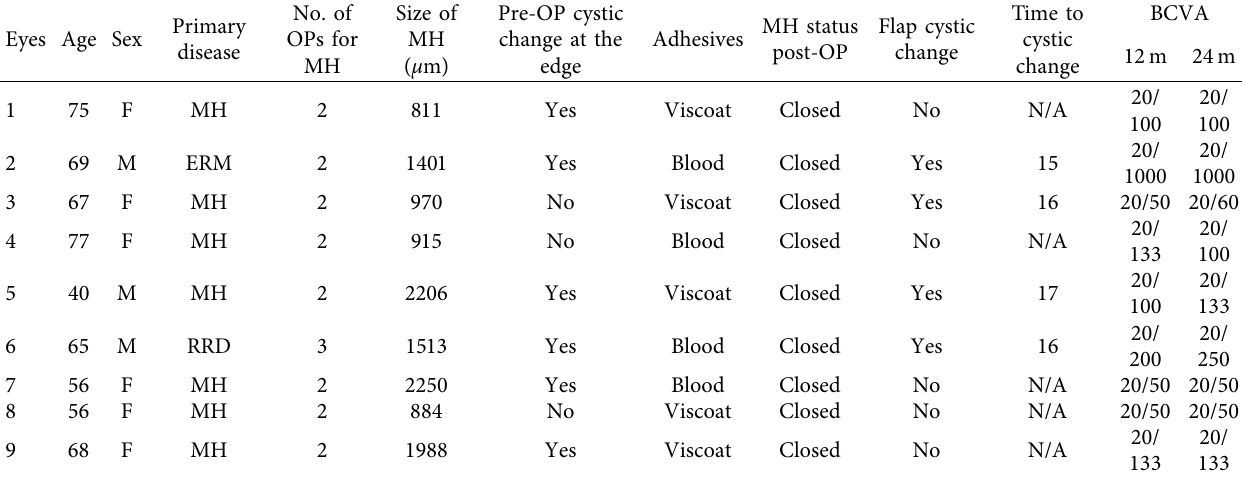
Table 1: Pre and postoperative demographics.